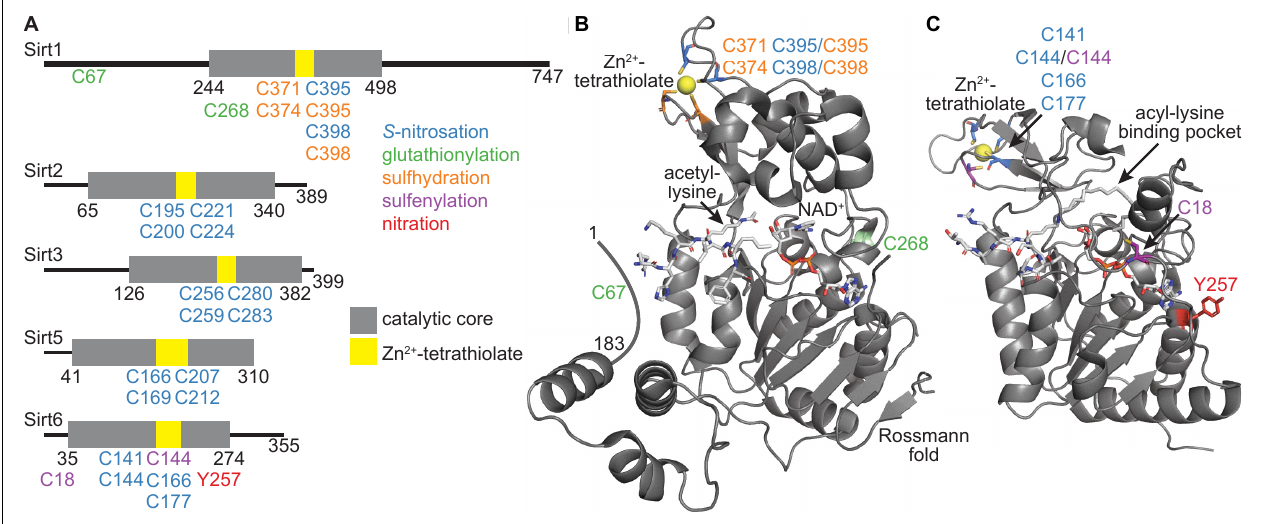
FIGURE 1 | Human sirtuin domain organization and tertiary structure of the catalytic core. (A) Linear representation of Sirt1, Sirt2, Sirt3, Sirt5, and Sirt6. Gray represents the catalytic core, with yellow denoting the Zn 2 + -tetrathiolate region. (B) Tertiary structure of the catalytic core and activator-binding domain of Sirt1 (PDB ID: 4ZZJ) with structural features and target residues labeled. (C) Tertiary structure of the catalytic core of Sirt6 (PDB ID: 7CL1) with structural features and target residues labeled. Blue residues denote sites of S -nitrosation, green residues denote sites of glutathionylation, orange residues denote sites of sulfhydration, purple residues denote sites of sulfenylation, and red residues denote sites of tyrosine